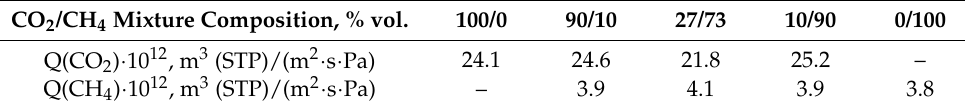
Table 5. Permeance of CO 2 /CH 4 mixtures of various compositions at 25 ◦ C. CO 2 /CH 4 Mixture Composition, % vol.